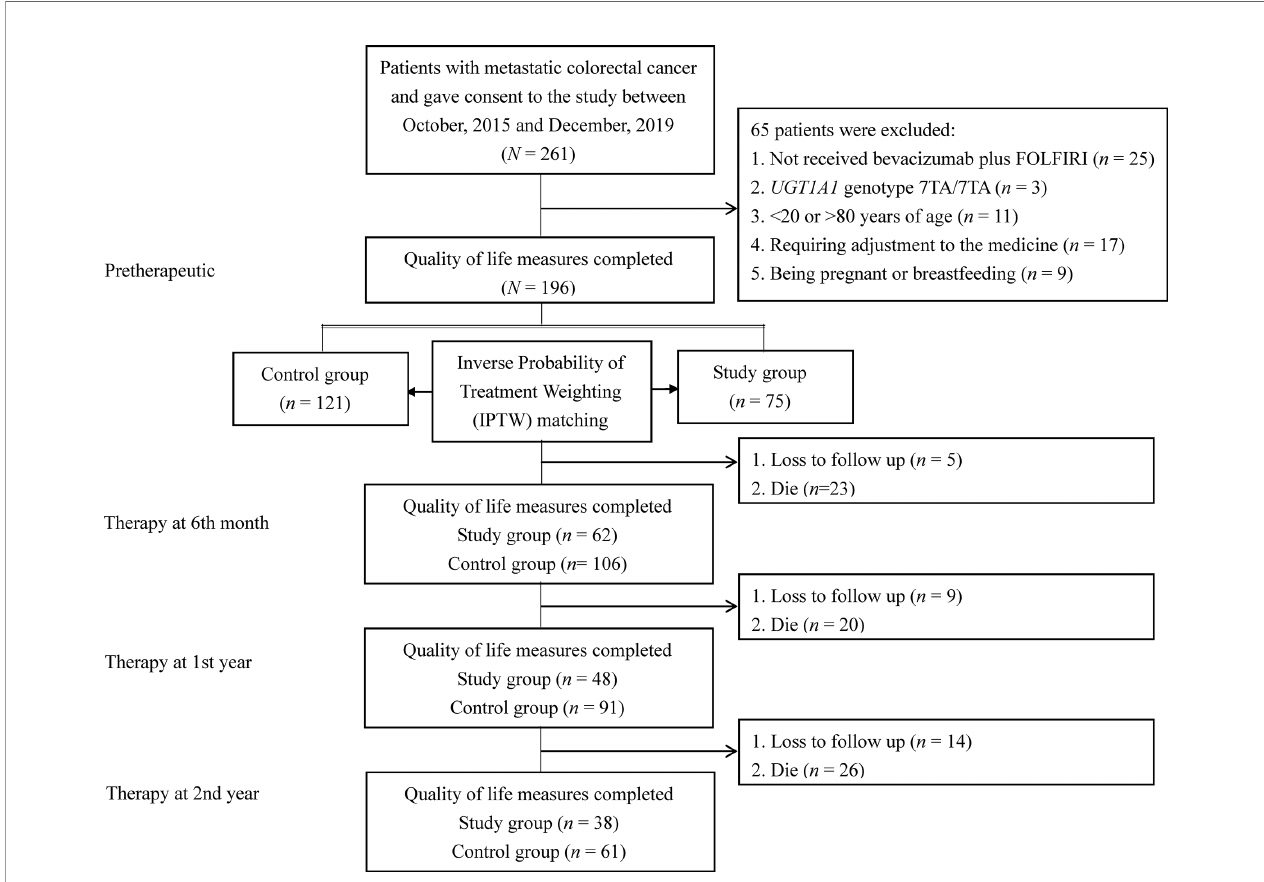
FIGURE 1 | Flowchart of sample selection for prospective cohort